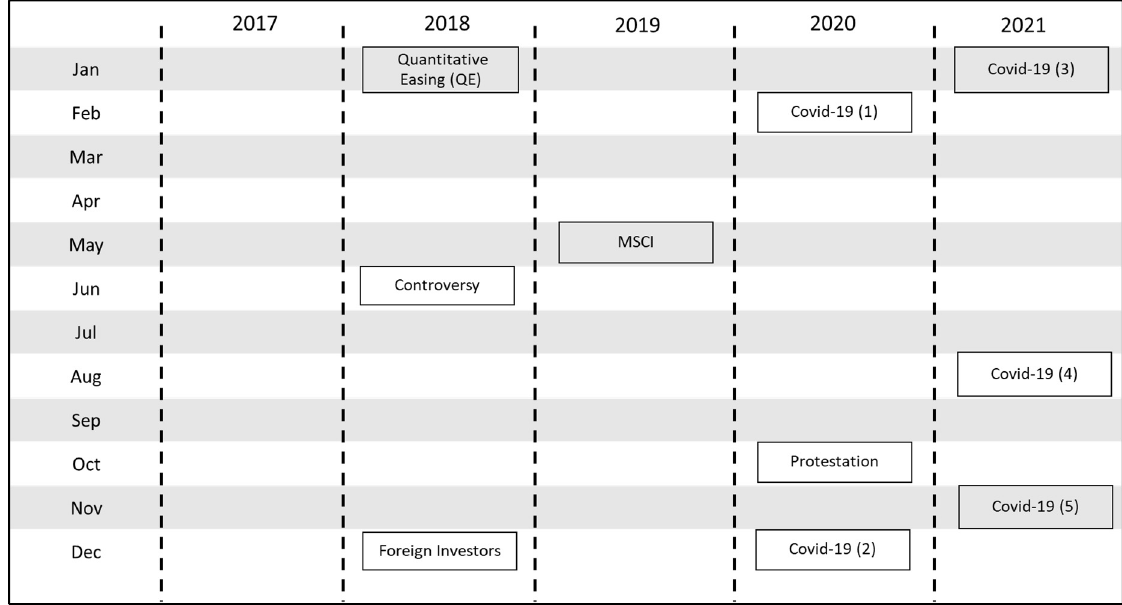
Figure 8. Crisis in Thailand during the years 2017–2021.